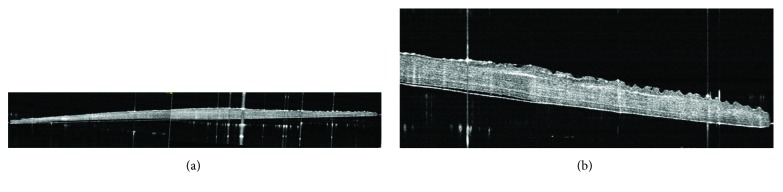
Optical coherence tomography (OCT) imaging demonstrated (a) nonuniform thickness of the fish scale scaffold and (b) the extent of grooves present on the edges of the scaffold.